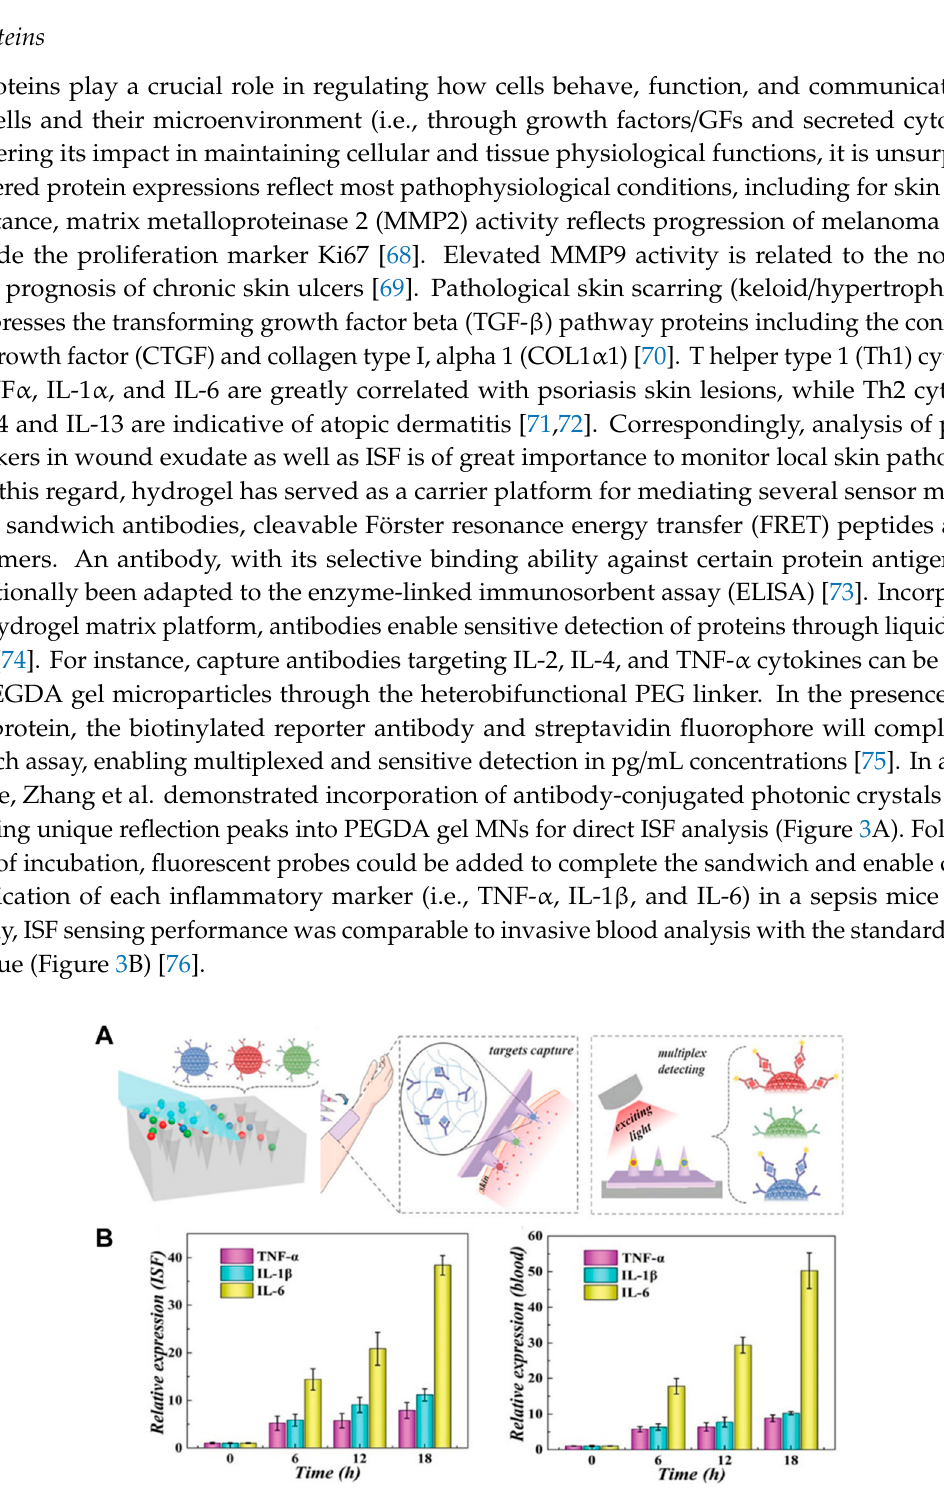
Figure 3 . Hydrogel-based platforms for monitoring protein biomarkers: ( A ) PEGDA gel Figure 3. Hydrogel-based platforms for monitoring protein biomarkers: ( A ) PEGDA gel microneedles microneedles (MNs) loaded with antibody photonic crystal barcodes enable isolation and (MNs) loaded with antibody photonic crystal barcodes enable isolation and simultaneous detection simultaneous detection of protein biomarkers from interstitial skin fluid. ( B ) Application of the of protein biomarkers from interstitial skin fluid. ( B ) Application of the encoded MNs in detecting encoded MNs in detecting inflammatory cytokines from sepsis mice (i.e., TNF- α , IL-1 β , and IL-6). inflammatory cytokines from sepsis mice (i.e., TNF- α , IL-1 β , and IL-6). Detected interstitial fluid Detected interstitial fluid (ISF) expressions were greatly comparable to that of the standard ELISA (ISF) expressions were greatly comparable to that of the standard ELISA technique of mice blood. technique of mice blood. Reproduced with permission from [76] . Copyright © 2019 John Wiley and Reproduced with permission from [76]. Copyright © 2019 John Wiley and Sons.